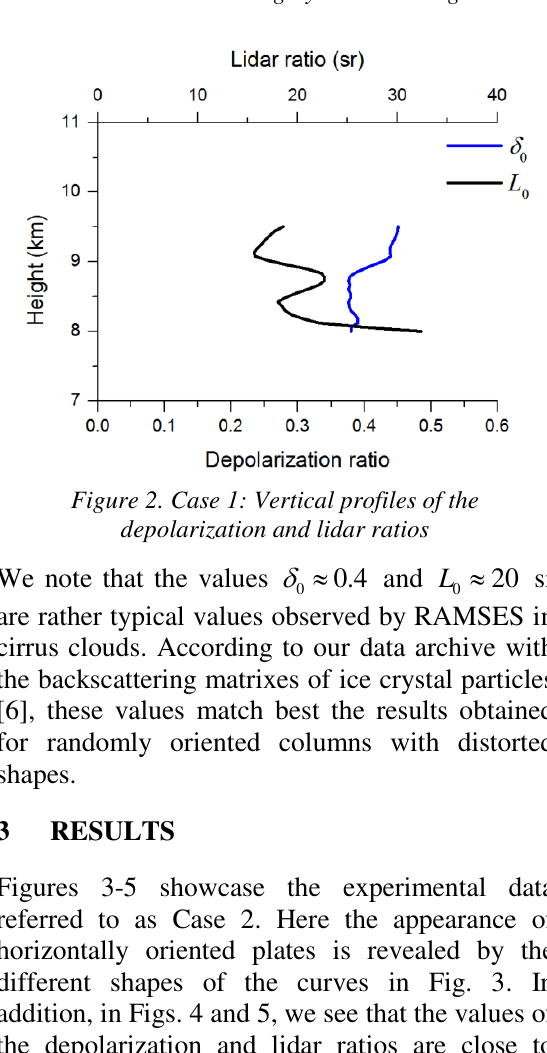
Figure 1 . Case 1: Four simultaneously measured profiles of Eqs.(2), (3), (5), and (6). Profiles are scaled so that maxima have roughly the same magnitude